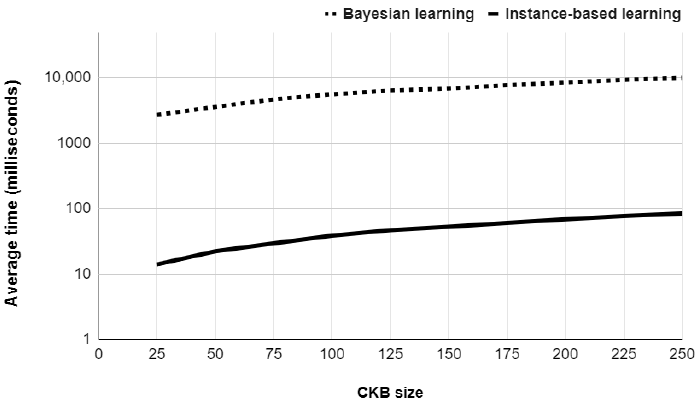
Figure 6. Average execution time comparison: instance-based learning vs. Bayesian learning method.